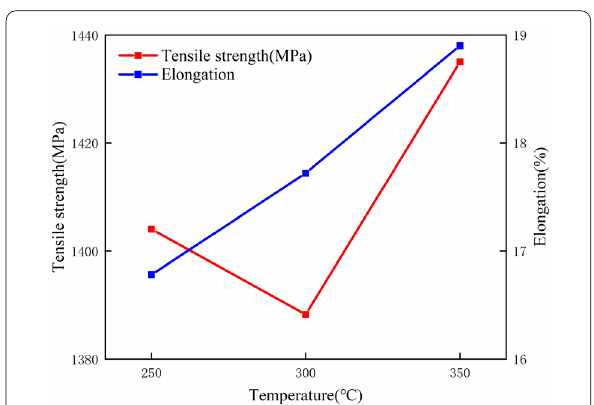
Figure 14 Tensile strength and elongation with different quenching